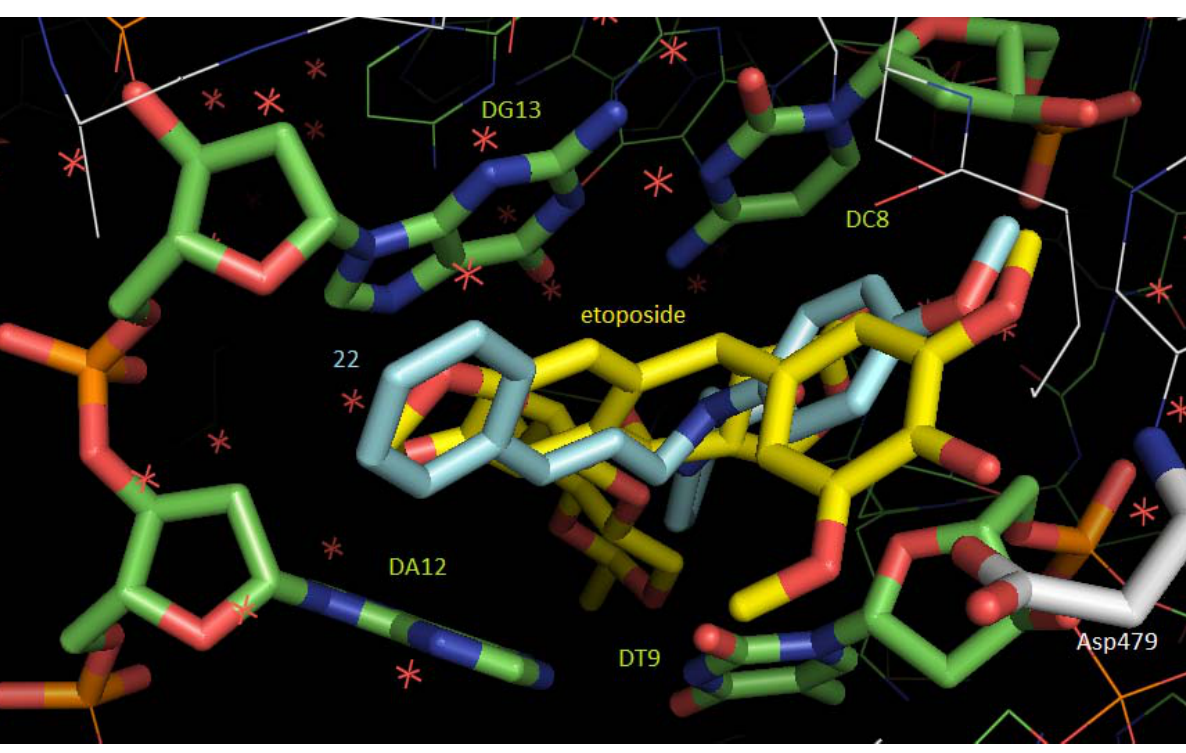
Figure 2. superposition of experimentally observed etoposide (carbon atoms in yellow) interactions and compound 22 (carbon atoms in cyan) docking interactions into the DNA (carbon atoms in green) binding site of topo II- α (carbon atoms in white); H atoms were removed to improve clarity (figure generated with PyMOL